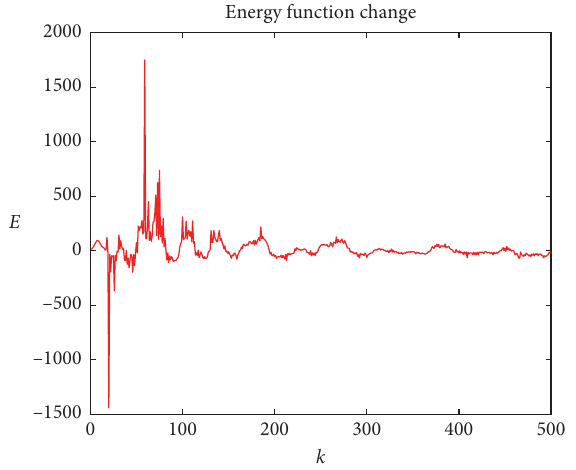
Figure 8: Change of energy